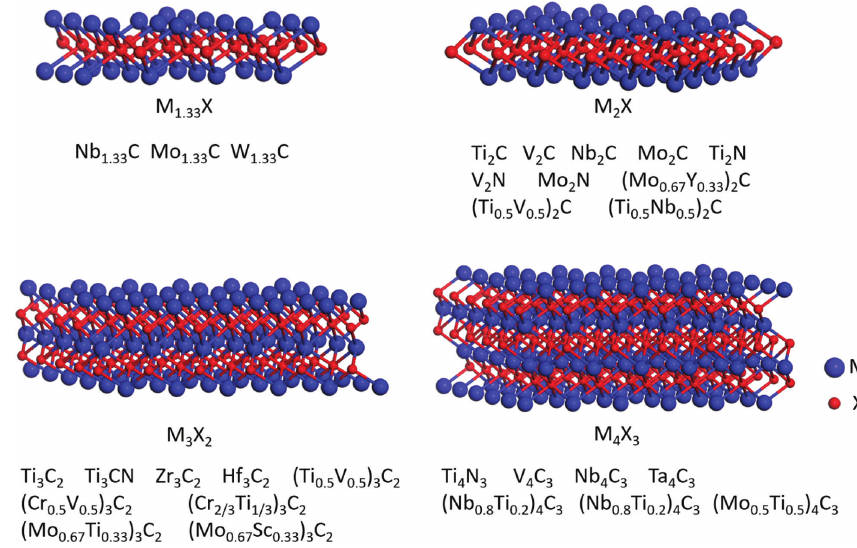
Figure 1: Overview of all experimentally synthesized MXenes, grouped by their structures. M X has ordered or random vacancies in M layers. Two, three, and four layers of M elements are interleaved by X elements for M 1.33 and M X , respectively. Note that this figure does not represent surface groups T. Detailed information and some examples of MXene phases 4 3 are in Figure 2.